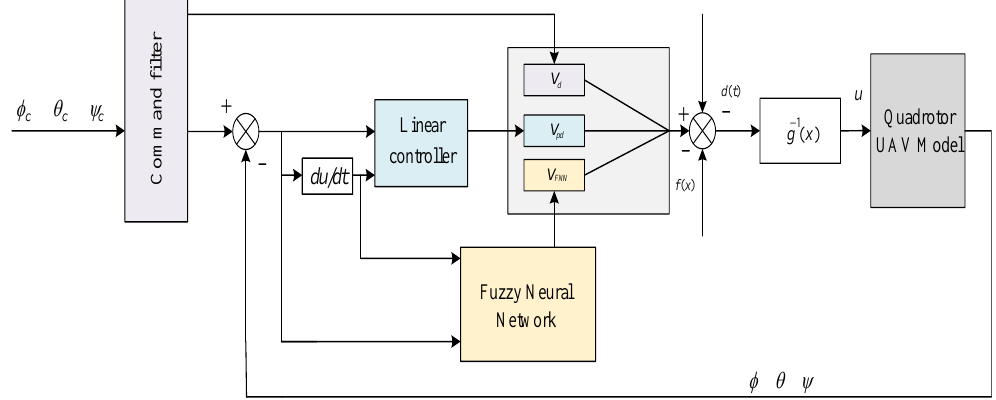
Figure 4. Attitude control structure diagram of system.